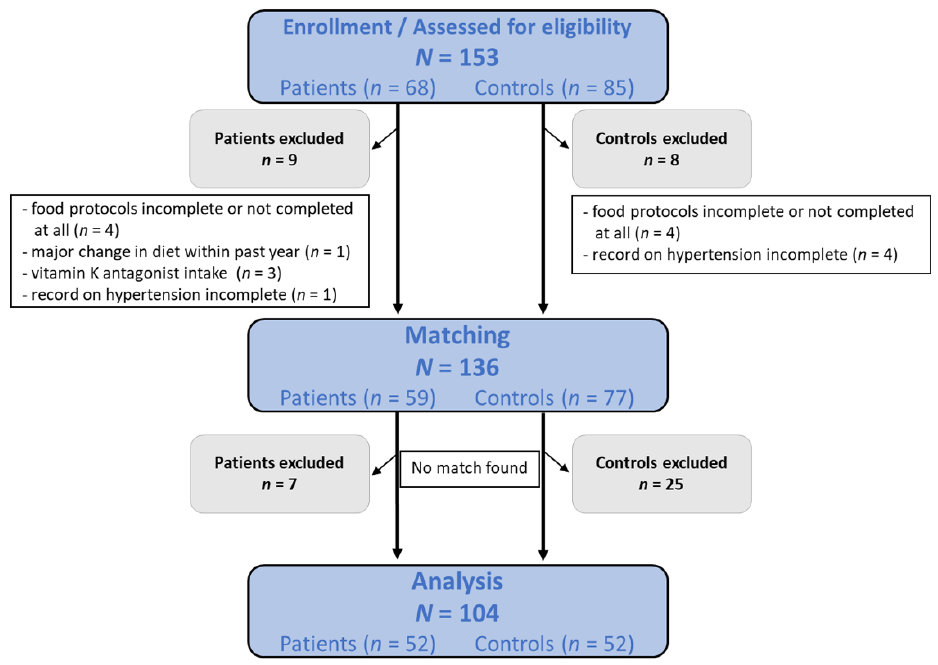
Figure 1. Flow chart of the study population selection.